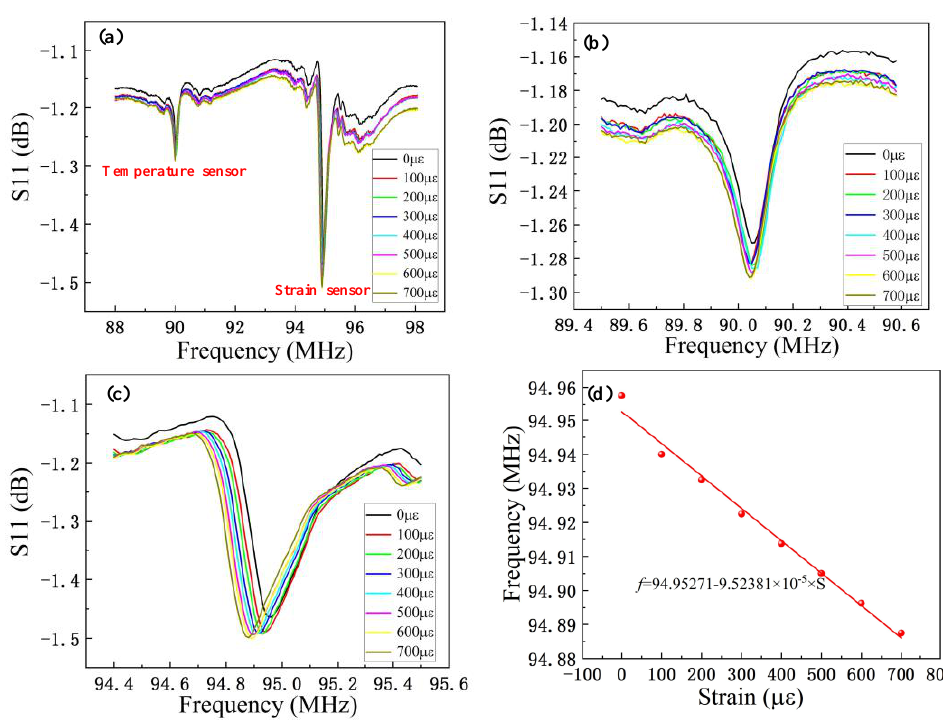
Figure 6. Integrated two-parameter sensor response to strain. ( a ) Strain response curve of the dual-parameter sensor at 25 ◦ C for 0–700 µ E . ( b ) Enlargement of the strain response curve of the temperature sensor. ( c ) Enlargement of the strain response curve of the strain sensor. ( d ) Curve displaying the relationship between the strain and frequency of the strain-sensitive unit.